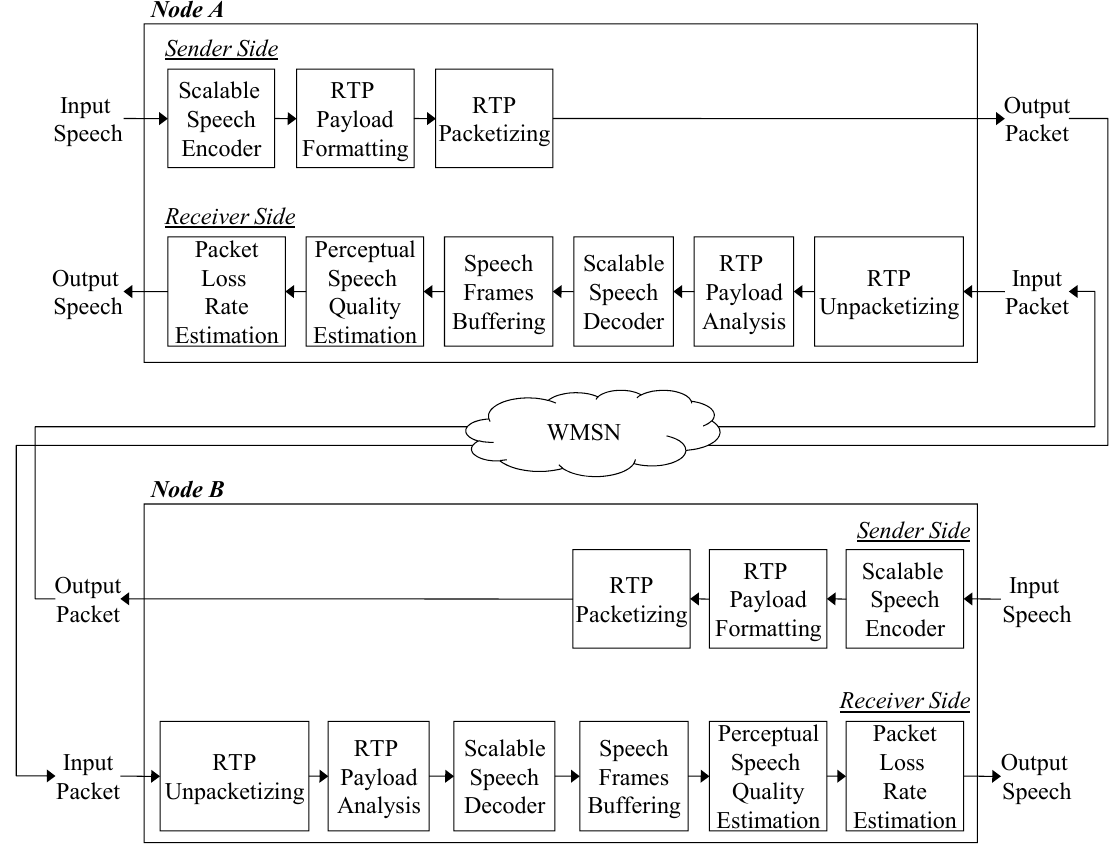
Figure 3. Packet flow for a speech streaming application employing the proposed ARST approach, where Nodes A and B represent the two communication parties.